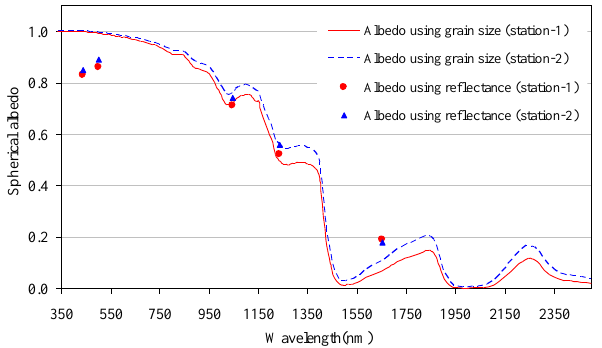
Fig. 11 Fig. 11. The comparison between spherical albedo retrieved using grain size and retrieved from the satellite reflectances for station-1 and station-2.